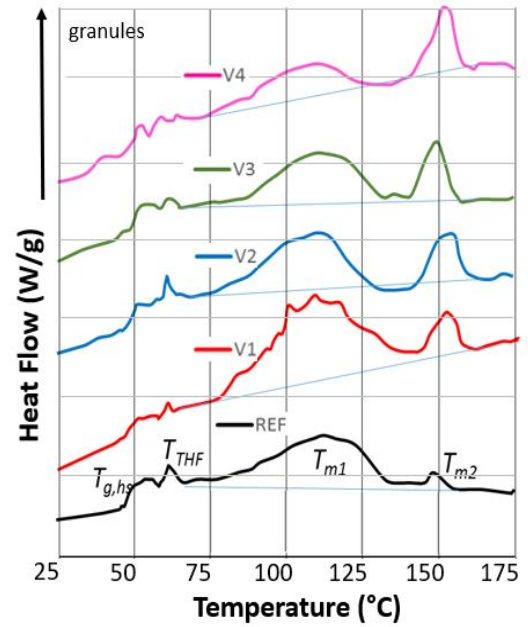
Figure 2. DSC traces of REF, V1 to V4, first runs (0.2 W/g) of granules with glass temperature T g,hs , the THF boiling temperature T THF , melting temperatures T m 1 and T m 2 , and corresponding melting and crystallization peaks.